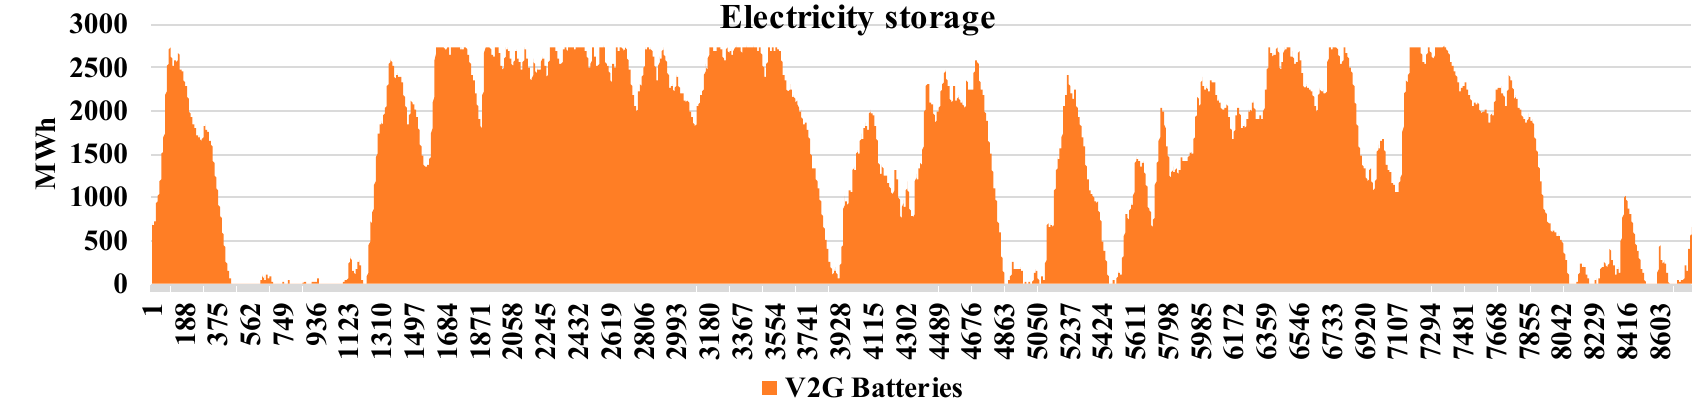
Figure 4. Hourly electric storage levels (MWh e ) for the year. Maximum storage capacity is 2750 MWh e . V2G batteries had a significant role in the energy system, providing flexibility on a daily and multi-day level. High capacities of V2G led to reduced need for seasonal gas storage.